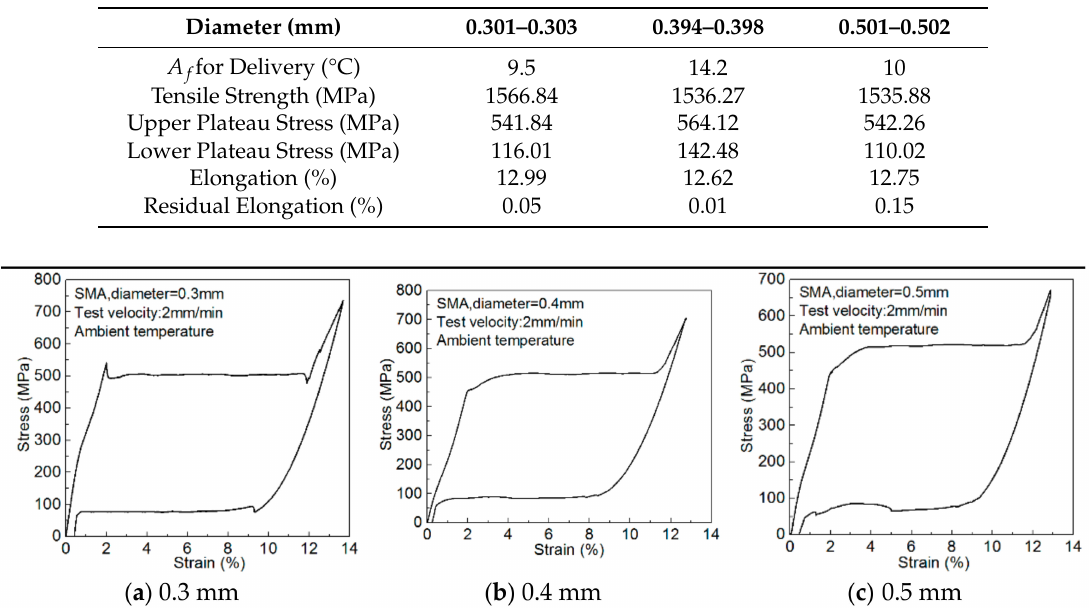
Table 1. The basic material parameters of Ni-Ti shape memory alloy wires.